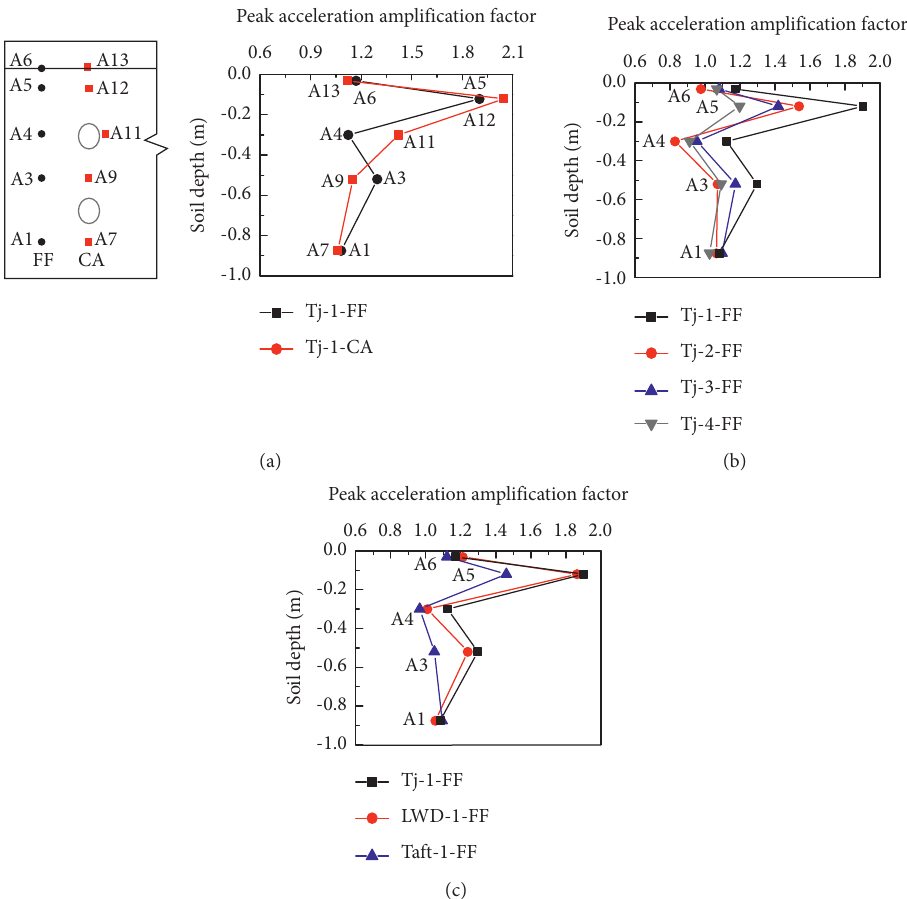
Figure 7: Acceleration amplification factor along the soil depth during ground motions. (a) Soil in different areas under the Tianjin wave. (b) Soil in far-field areas under Tianjin wave. (c) Soil in far-field areas under different seismic waves.